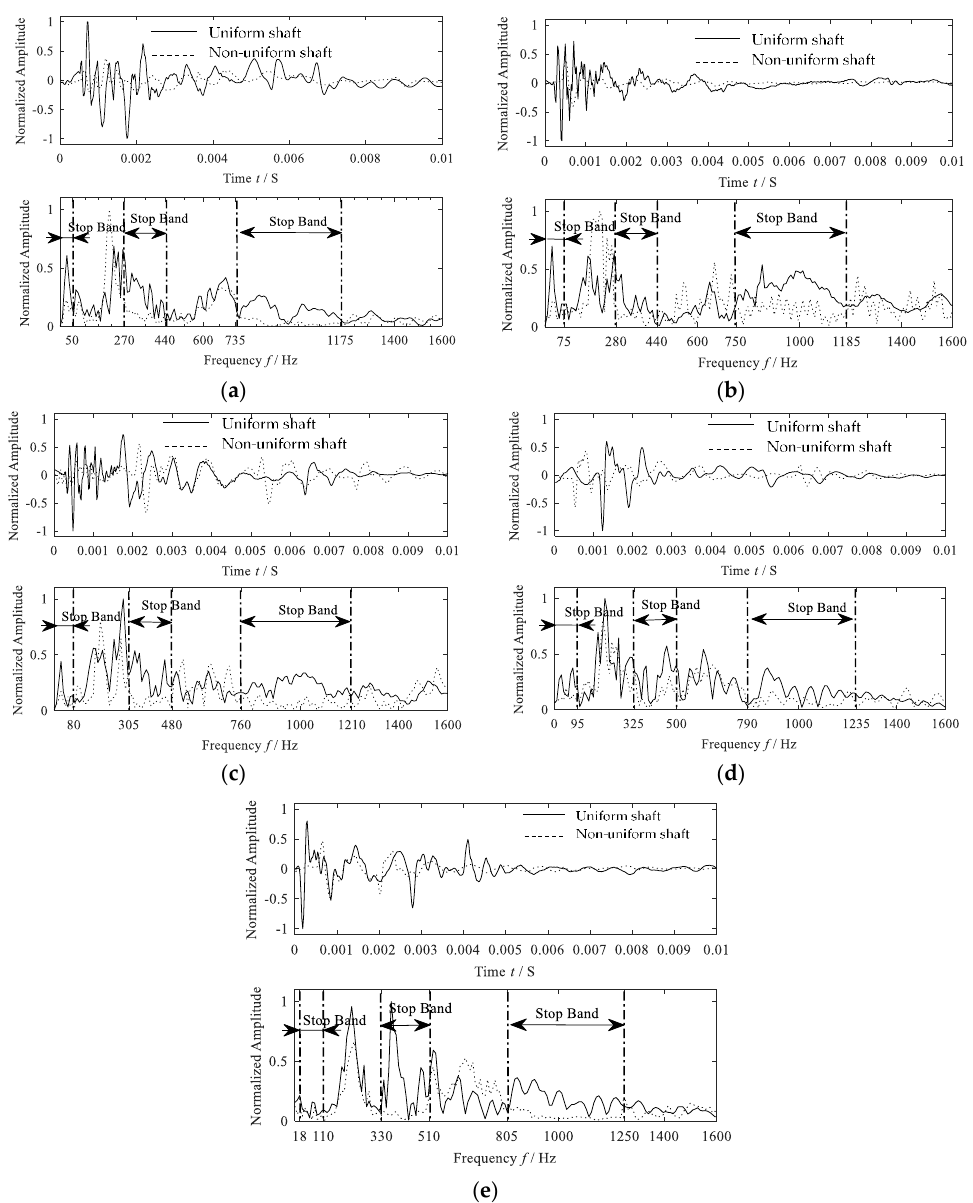
Figure 13. Experimental propagation characteristics derived from different rotating speeds, where ( a ) is for 0 Hz, ( b ) is for 10 Hz, ( c ) is for 20 Hz, ( d ) is for 30 Hz and ( e ) is for 40